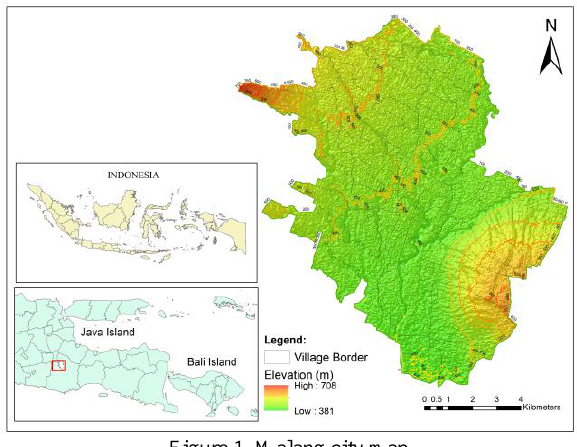
Figure 1. Malang city map Malang city is a second biggest city in East Java,